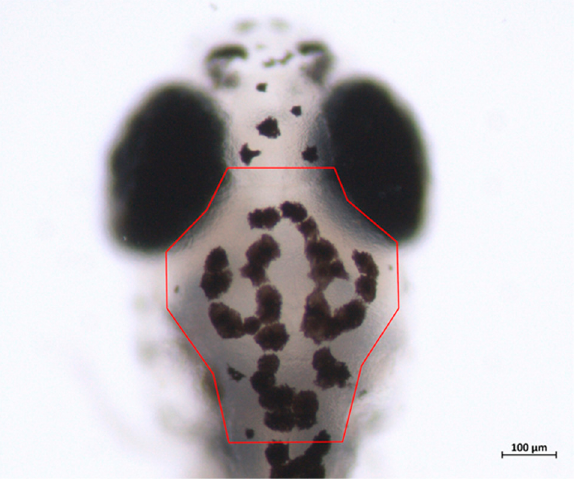
Figure 7. Region of interest (ROI) where the melanocyte density was compared between the control and 1% alcohol-treated zebrafish embryos at different developmental stages. (Red colour outline indicates the ROI). The ROI is defined as the area between the midline of the orbs and the base of the head, located most anterior part of the dorsal stripe.